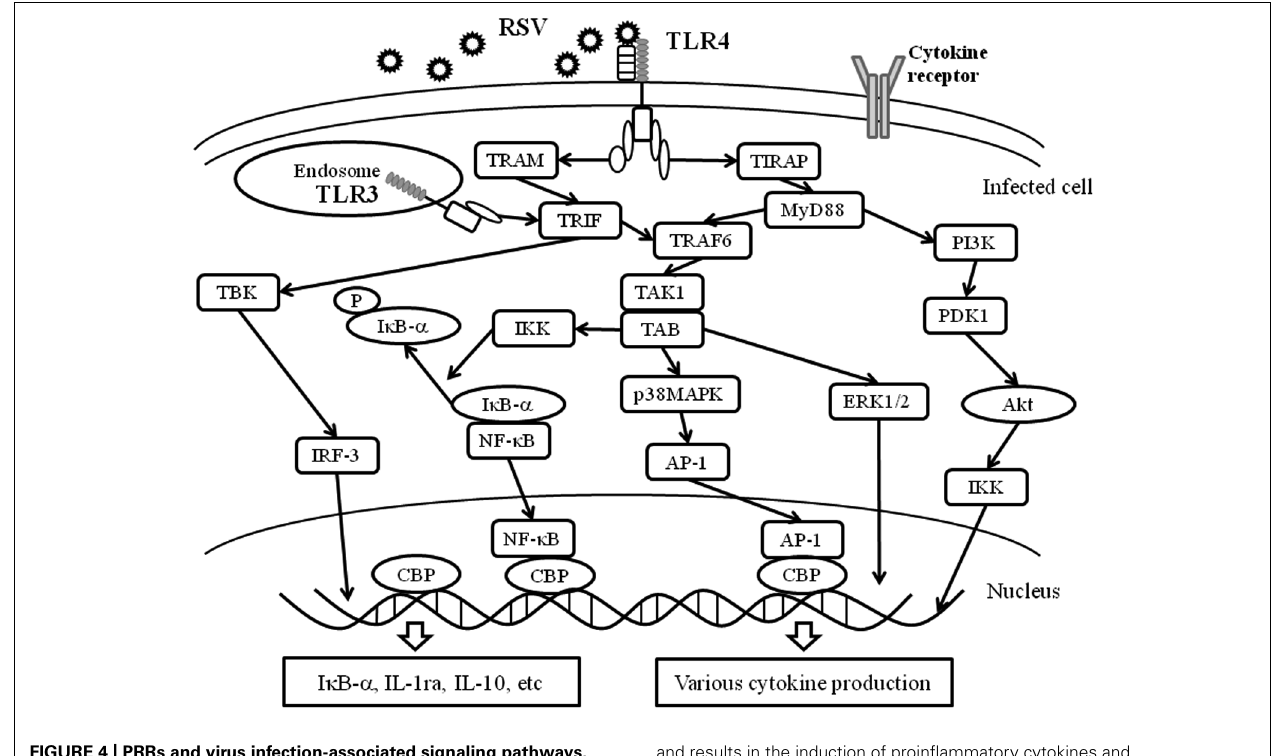
and results in the induction of proinflammatory cytokines and type I IFNs. Moreover,TLR4 is able to signal via both MyD88-dependent and -independent pathways and is able to activate a response via IRF-3, NF- κ B, AP-1, ERK and IKK.These receptors recognize RSV and induce an appropriate antiviral innate immune response in the infected cells. Akt, protein kinase B; ERK1/2, extracellular signal regulating kinase1/2; PDK1,